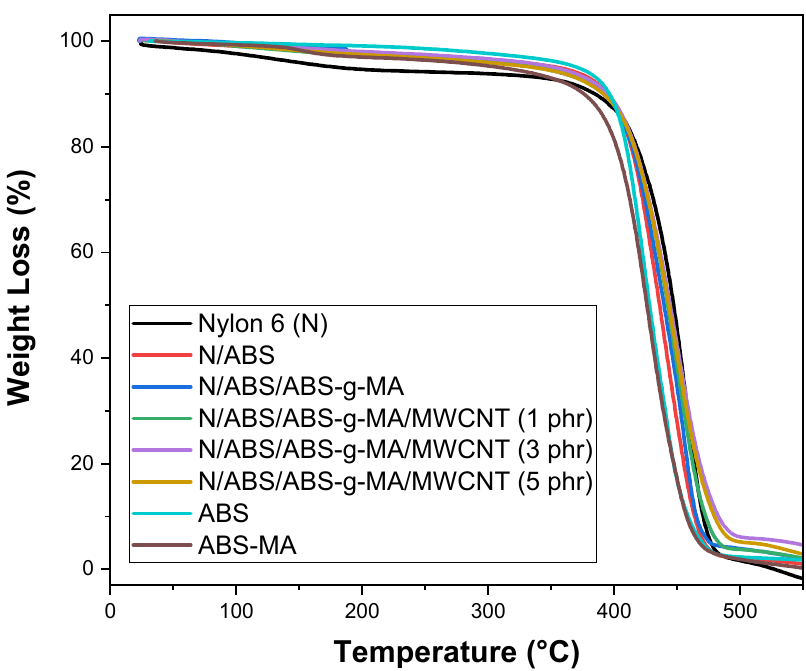
Figure 12. TG curves of Nylon 6, Nylon 6/ABS, Nylon 6/ABS/ABS-g-MA, and nanocomposites as a function of carbon nanotube content. N = Nylon 6.